Question: Which kind of chart has been used to present this data?
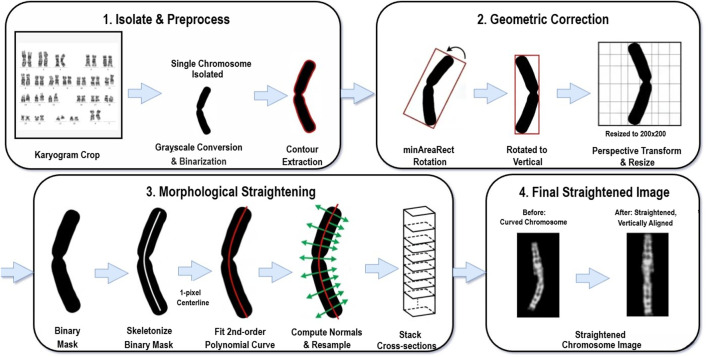
Answer: line